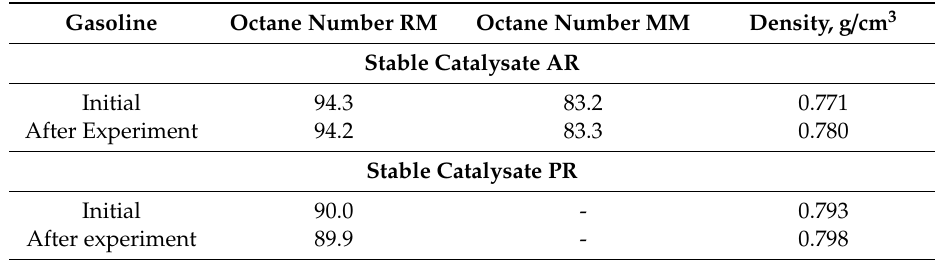
Table 3. Characteristics of gasoline fractions of stable catalysate AR and stable catalysate PR before and after catalytic treatment.